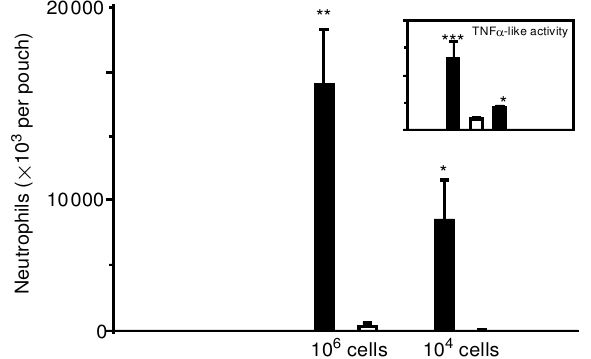
FIG. 5. Effects of replenishment with alveolar macrophages on LPS-induced recruitment of neutrophils and TNF- a like activity in rat air pouches. For the recruitment, air pouches were pretreated with 6 ng of cycloheximide for 2 h, then replenished with 10 6 macrophages for four animals or with 10 4 macrophages for six animals under a volume of 1 ml for 0.5 h, then stimulated with LPS (200 ng) or PBS for 2 h under a volume of 1 ml. Results are expressed as mean SEM of total number of cells. For the TNF- a like activity (inset), the same conditions were used and results are expressed as mean SEM of this activity recovered in the air pouch washing supernatants. Comparison for each replenishment group was performed for LPS ( j ) vs. PBS ( h ) ( P , 0.05, P , 0.01, P , 0.001).